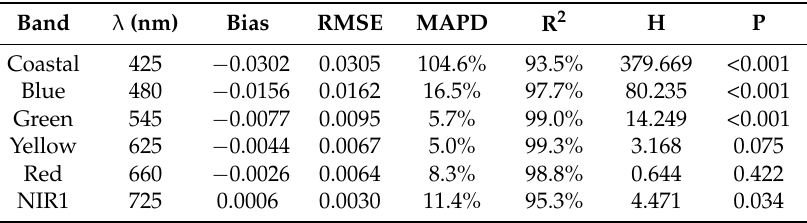
Figure 3. Comparison of atmospherically-corrected r rs spectra of the first six WoldView-2 spectral bands, of a cross-track sample of a shallow water over sandy bottom in an image segment that is least affected by glint in both Image 1 and Image 2 (dashed line represents 1:1 relationship). Table 2. Band specific bias, RMSE, RMSD, and R 2 , as well as Kruskal-Wallis H test computed for atmospherically-corrected r rs spectra of the WoldView-2 spectral bands, of a cross-track sample of a shallow water over sandy bottom in an image segment that is least affected by glint in both Image 1 and Image 2 ( n = 319).